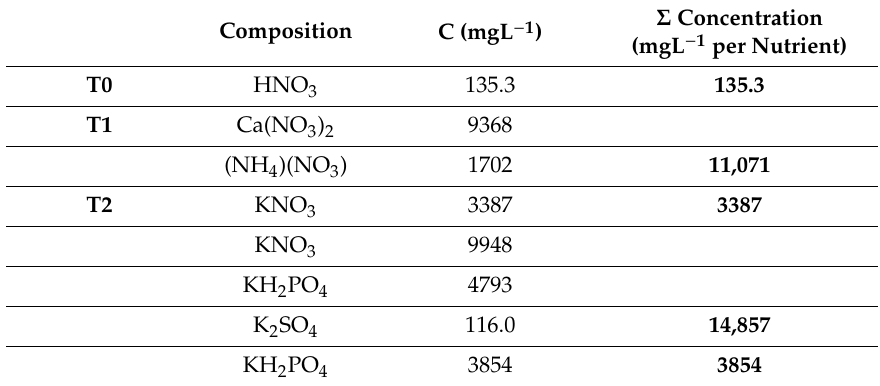
Table 1. Irrigation tanks composition and cumulative (target) ionic species concentrations.